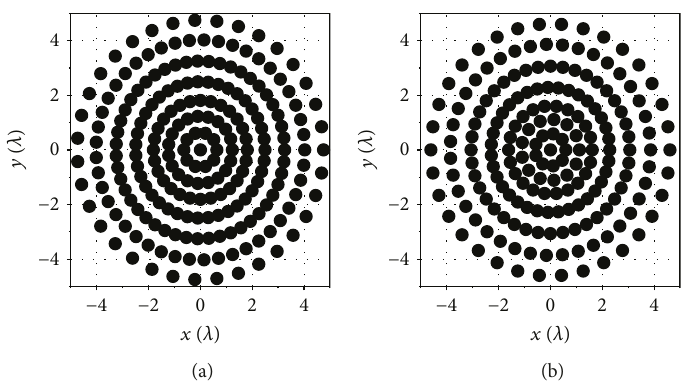
Figure 7: Layouts of the SUACRA 3 and 4: (a) SUACRA 3 (224 elements) and (b) SUACRA 4 (193 elements).